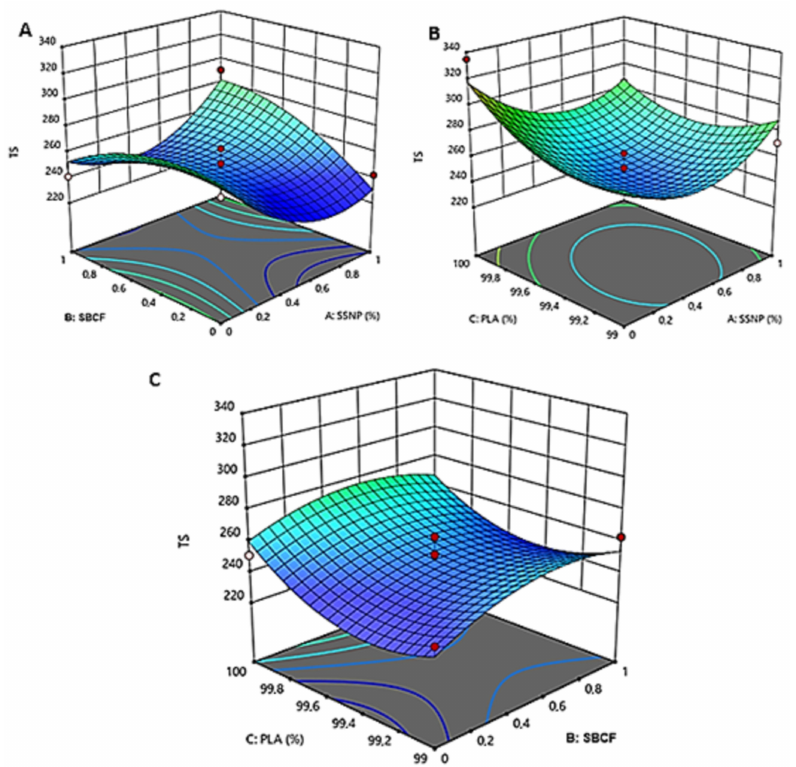
Figure 4. The 3-D surface plot of thermal stability (TS) as a function of SSNP, SBCF, and PLA loadings: interaction effects of PLA and SBCF ( A ), SBCF and SSNP ( B ), PLA and SSNP ( C